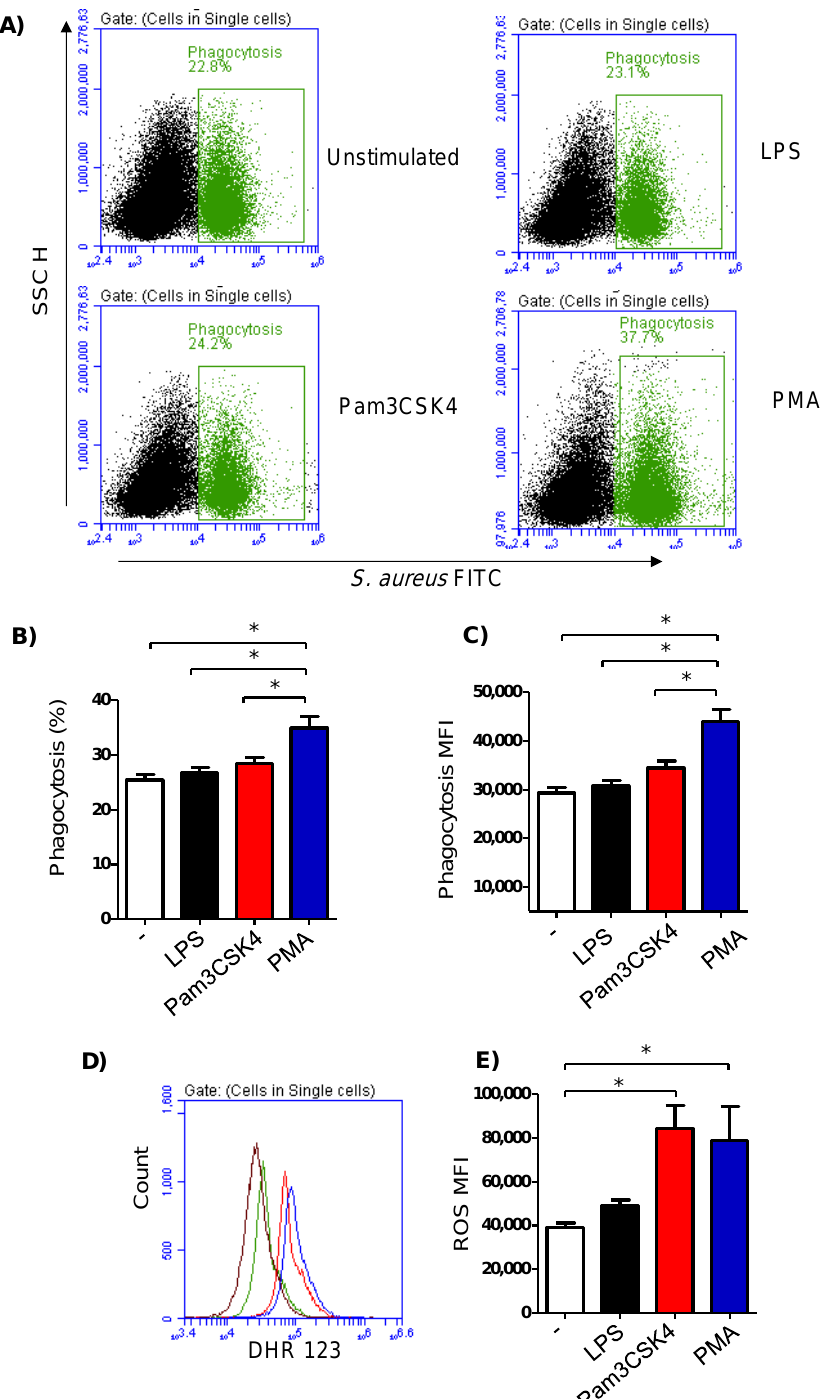
Figure 4. Flow cytometric analysis of phagocytosis and ROS production by milk cells. ( A ) Cells were separated from unstimulated and stimulated milk samples, incubated with FITC-conjugated S. aureus bacteria, and analyzed by flow cytometry. Phagocytosis-positive cells were identified based on their enhanced green fluorescence in FL-1. The percentage of phagocytosis-positive cells ( B ) as well as their main fluorescence intensity ( C ) were calculated for stimulated and unstimulated milk cells and presented graphically. ( D ) ROS production was analyzed after staining the cells with DHR-123 by measuring the mean green fluorescence intensity using flow cytometry. ( E ) ROS production in unstimulated and stimulated cells was measured and presented graphically ( n = 7 camels). * indicates statistically significant differences between the groups ( n = 7 camels; p values less than